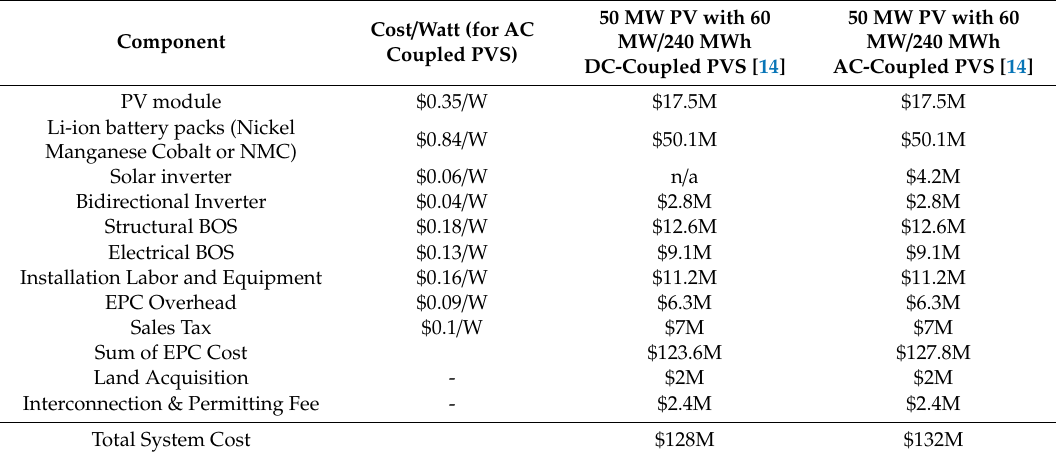
Table 4. System installed cost breakdown for AC vs. DC Coupled